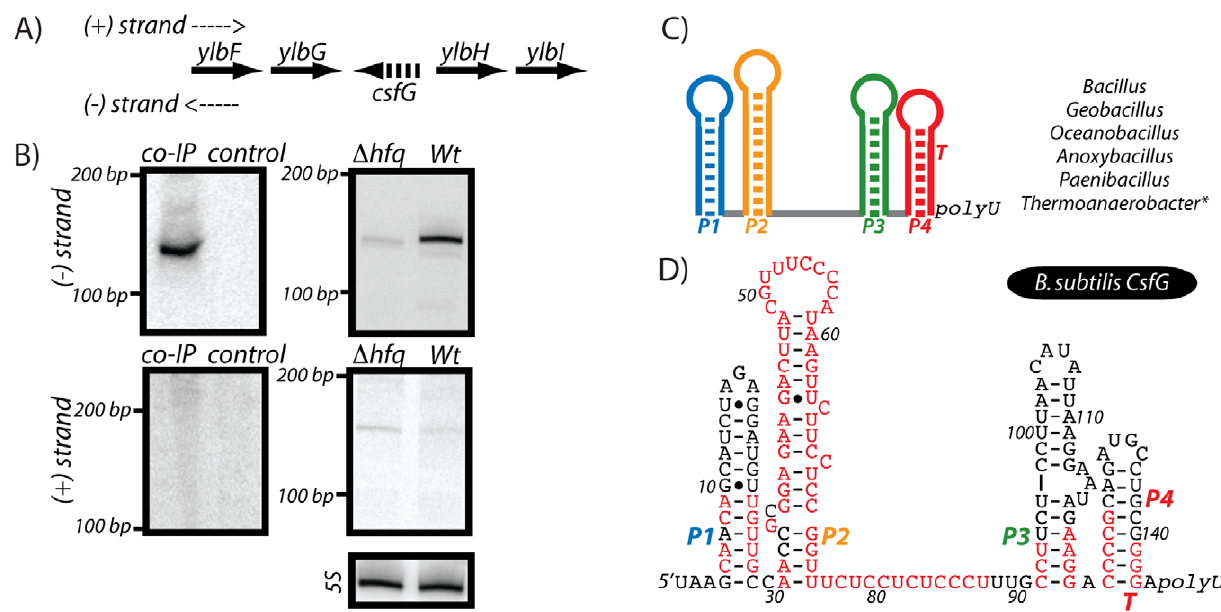
Figure 8. Coimmunoprecipitation of CsfG, an sRNA conserved in Bacillaceae , with Hfq. (A–B) Previously, an orphan riboswitch was identified upstream of the ylbH gene in certain Bacillaceae [61,71–72]. In this study, we find that this RNA element is not likely to be conserved as a 5 9 leader region for the ylbH gene, but is instead transcribed from the reverse genomic strand as a putative sRNA, which has been recently coined csfG [62]. This region was detected by northern blot analyses using oligonucleotide probes to hybridize to the region upstream of the ylbH gene ( + strand) and to the reverse complement of that sequence ( 2 strand). A signal was only observed for an RNA sequence transcribed from the reverse complement strand, consistent with synthesis of CsfG. This putative sRNA also appeared to coIP with Hfq by northern blot analysis. Furthermore, the intracellular abundance of the sRNA was moderately decreased in a D hfq strain. (C–D) Consensus secondary structure diagram of the recently identified sRNA, CsfG (data not shown; [62]). Residues in red represent 95% conservation. This primary sequence and secondary structure consensus pattern was generated from covariance model searches (data not shown).